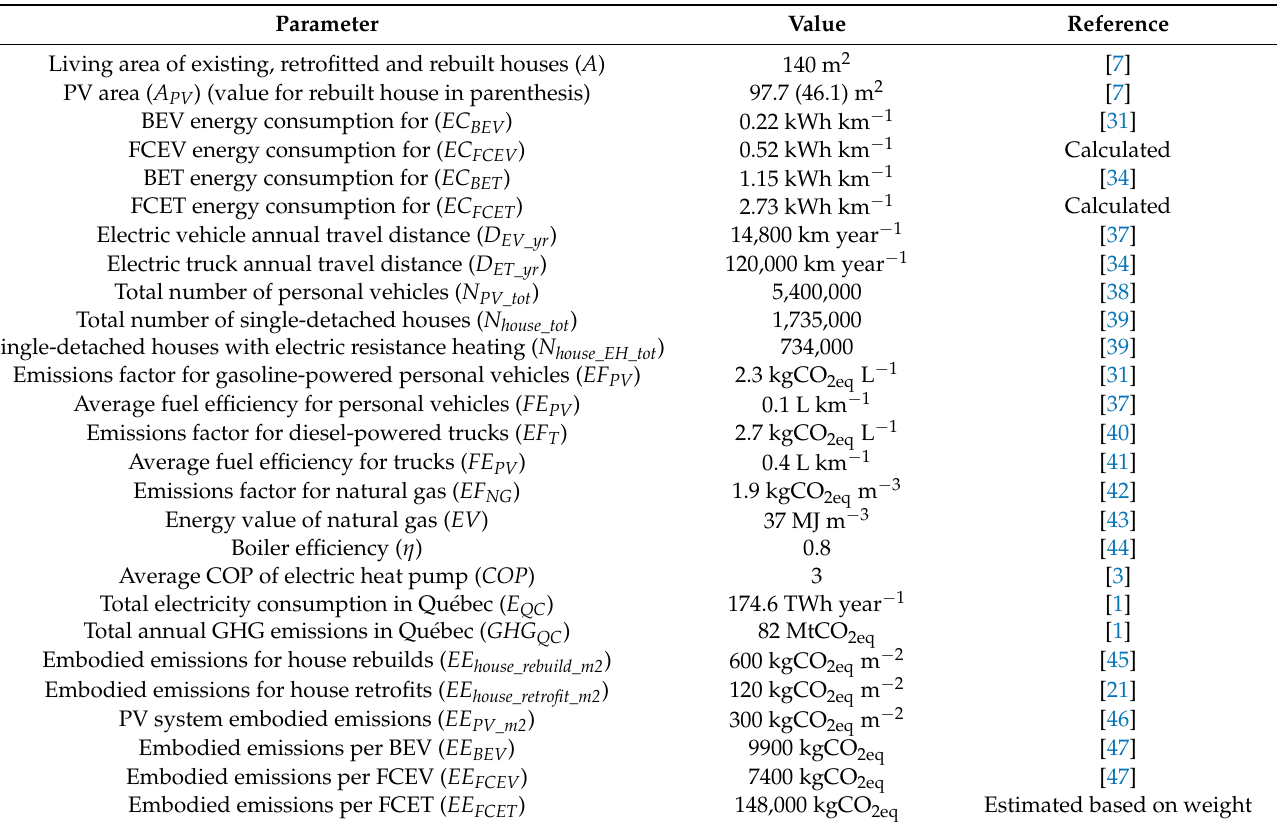
Table 3. Parameter values used in the